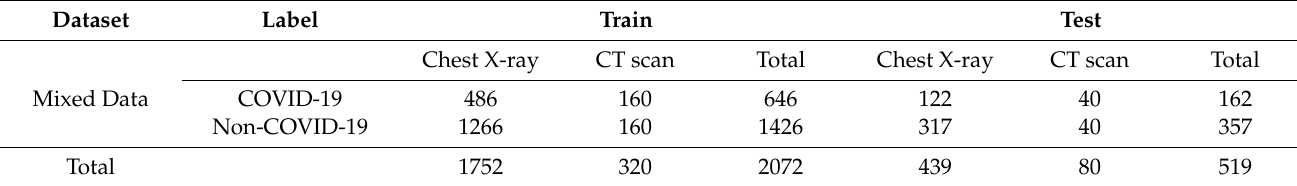
Figure 3. Representative sample images of chest X-rays and CT scans used in the mixed dataset adopted for analysis. Table 1. Summary of the mixed dataset used in the analysis, including training and test sets.